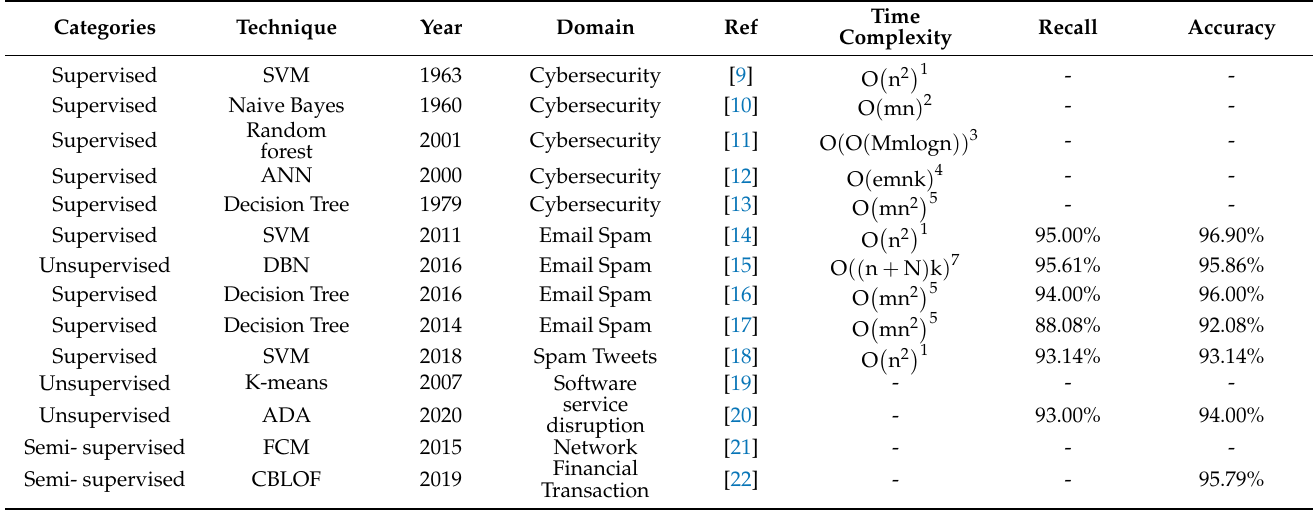
Table 1. Anomaly detection-related work